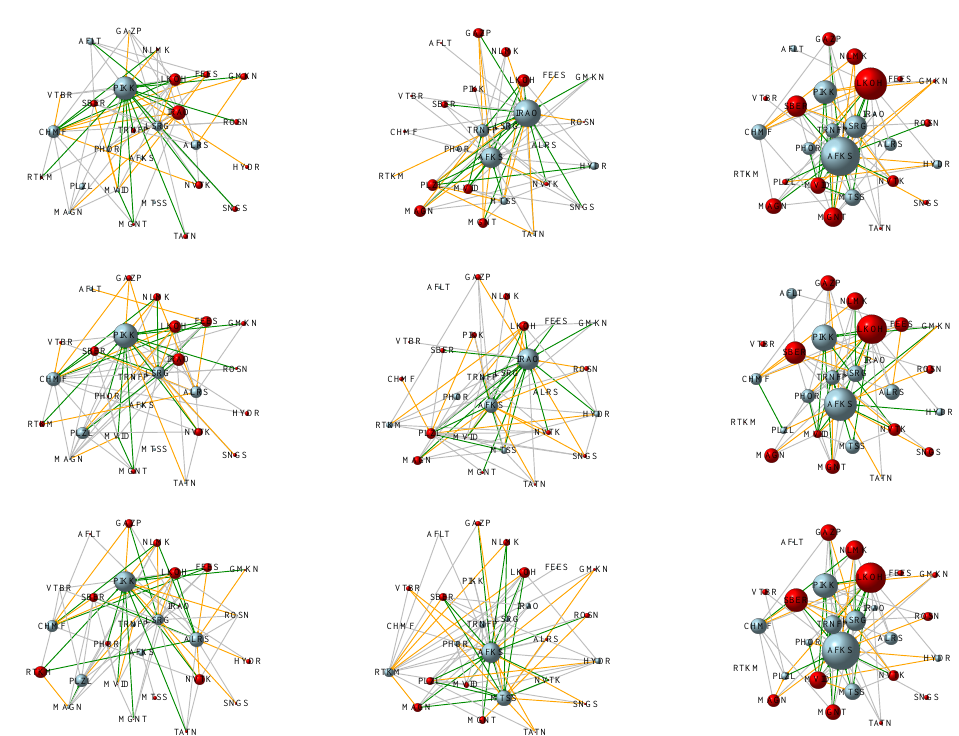
Figure 13. Net Pairwise Directional Connectedness by politic crisis period (from 1 January 2014 to 1 March